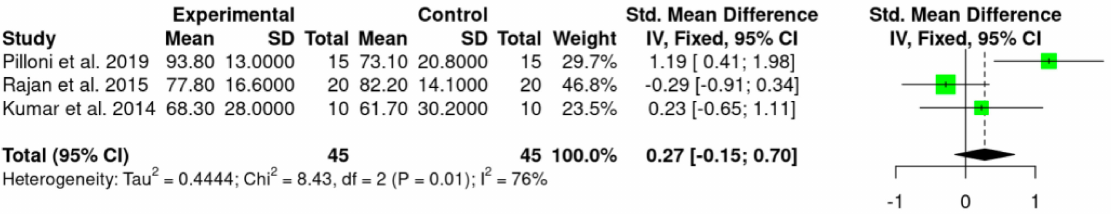
Figure 2. Forest plot with respect to the primary outcome (MRC).